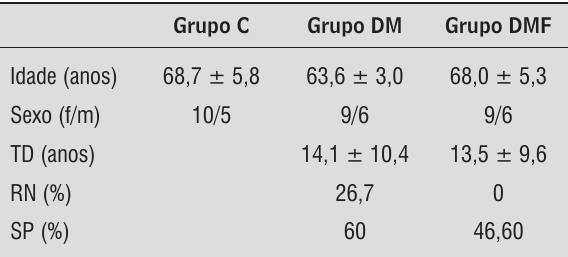
A Tabela 1 apresenta os dados de descrição